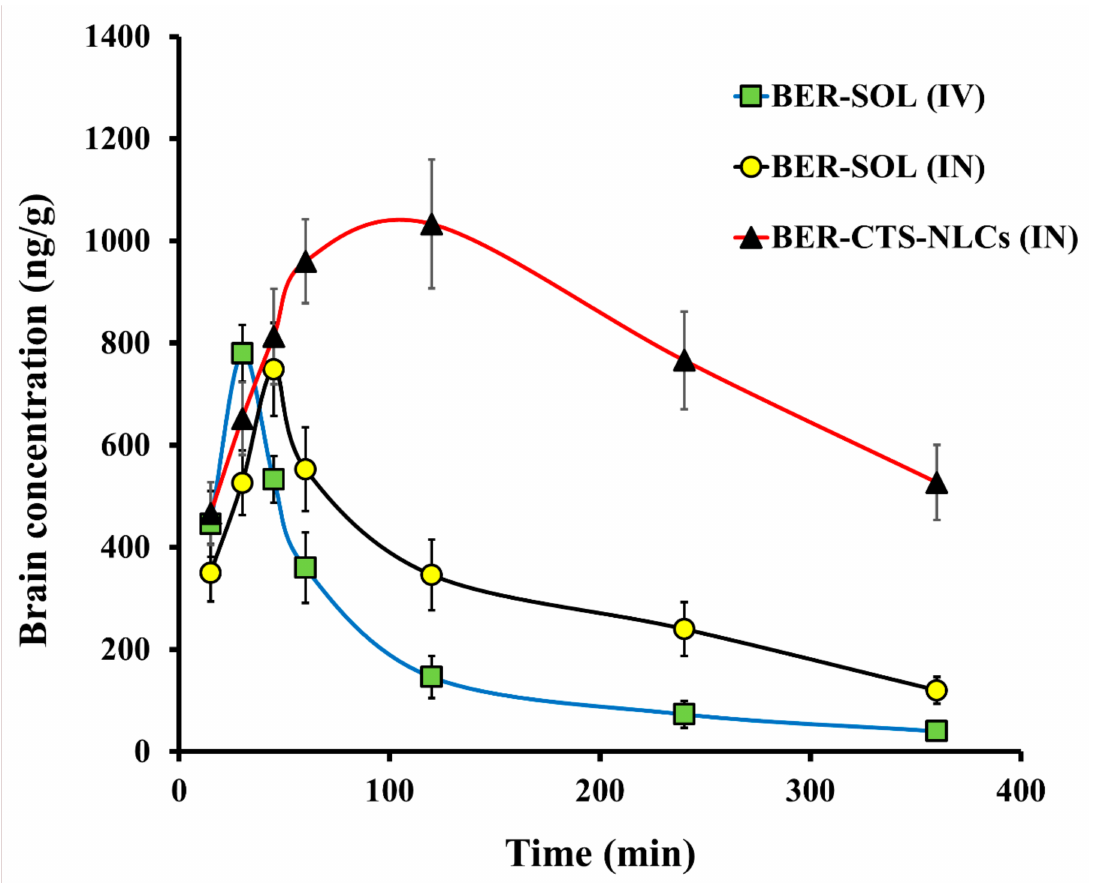
Figure 7. The levels of berberine (BER) in rat brain after administration of BER-SOL (IV), BER-SOL (IN), and BER-CTS-NLCs